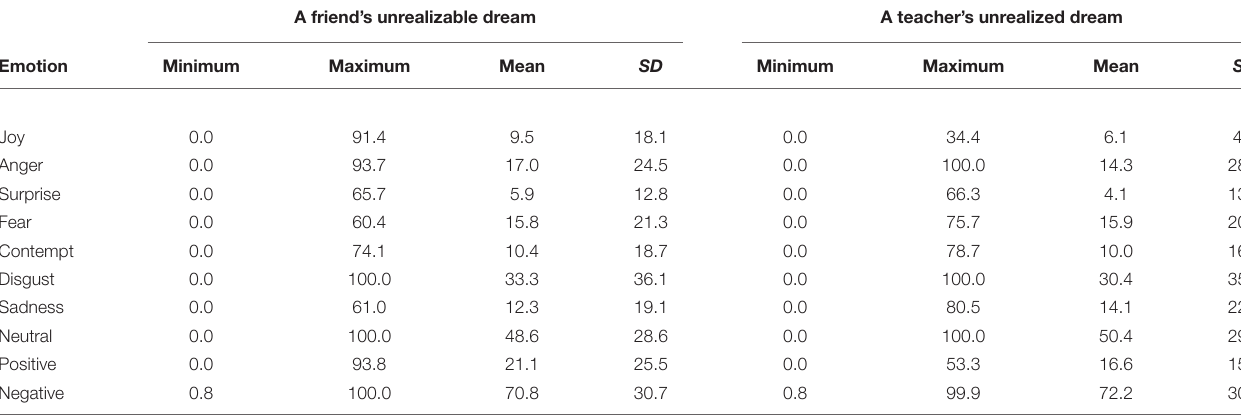
TABLE 3 | Proportional time of emotion during the participants’ performance in different scenarios (unit: percent).